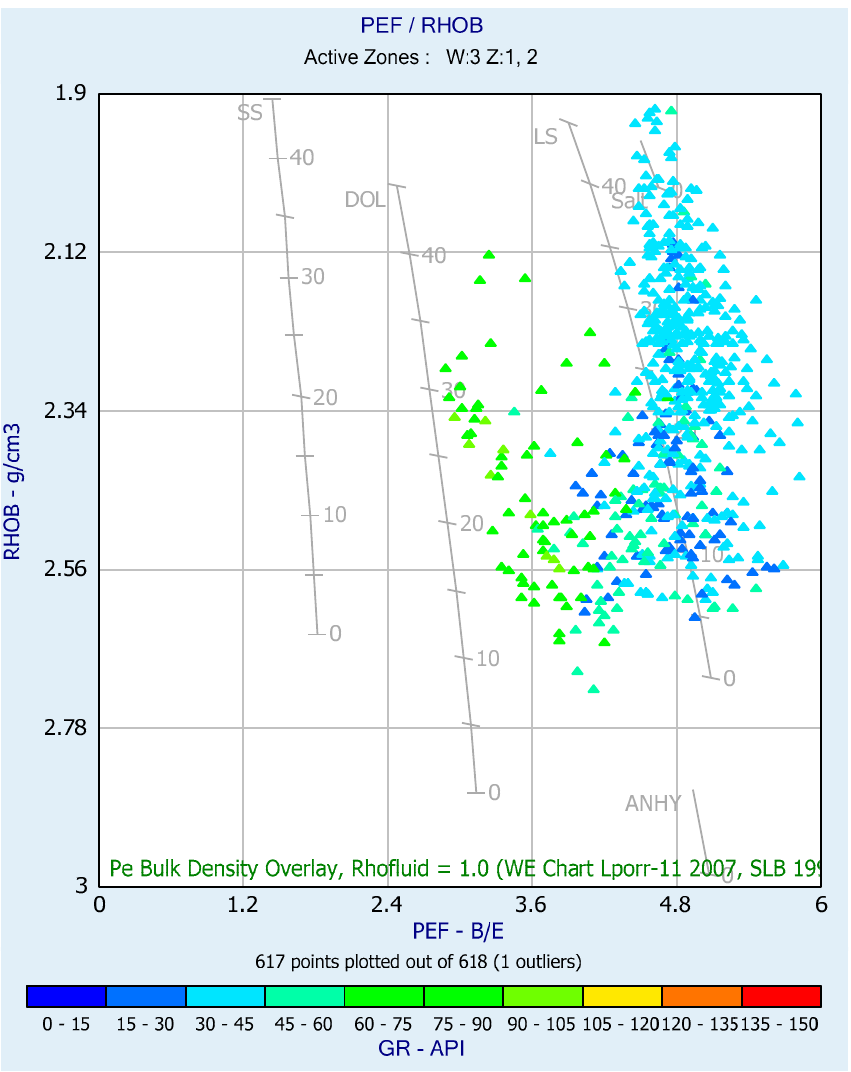
Figure 5. QGF well 03 PEF via RHOB cross-plot of reservoir zone.